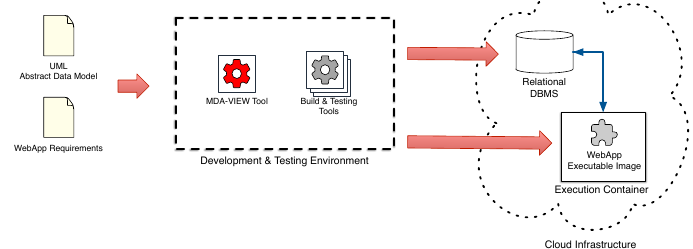
Figure 7. Development of a web